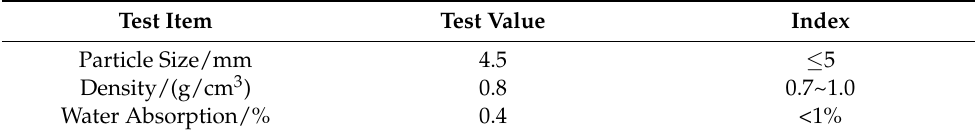
Table 1. Physical indexes of the high-viscosity modifier.